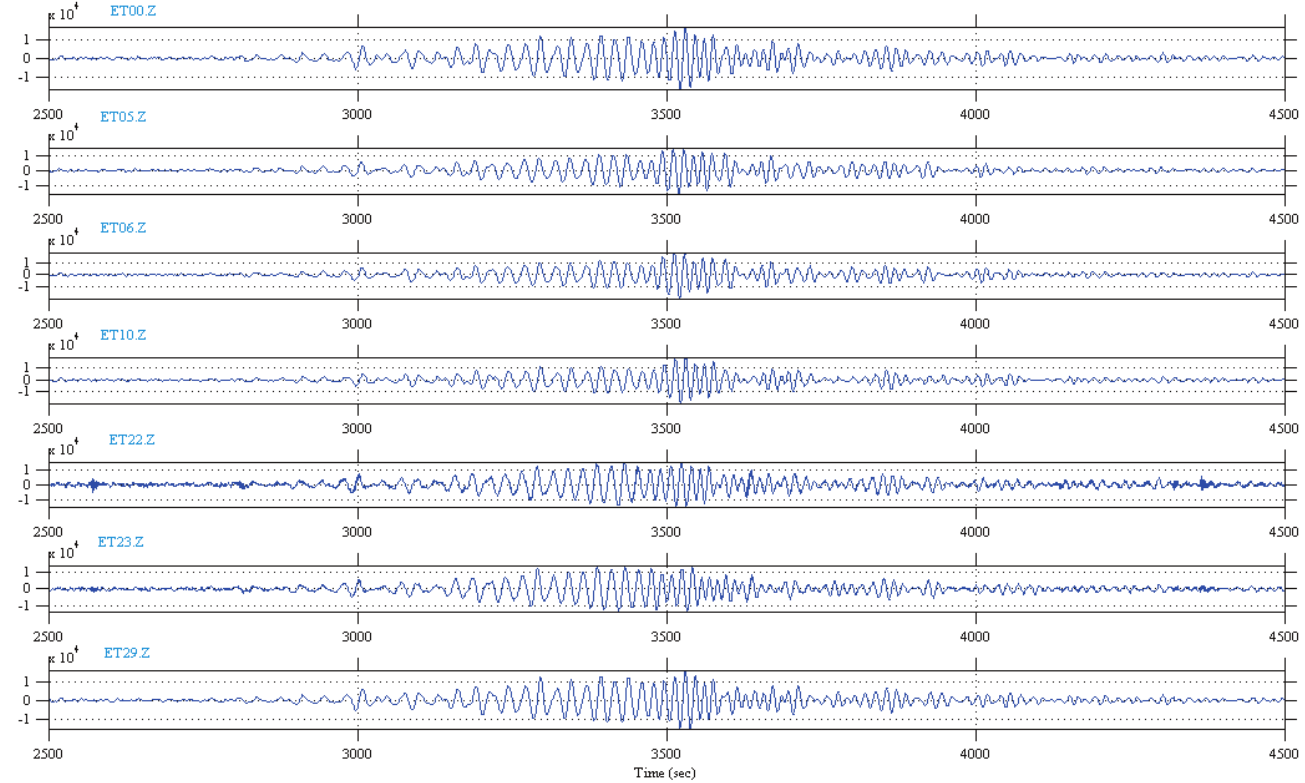
Figure 2. Vertical components of a teleseism that occurred in Japan on 16.08.2005, recorded by the mobile network of the Istituto Nazionale di Geofisica e Vulcanologia (INGV), sezione di